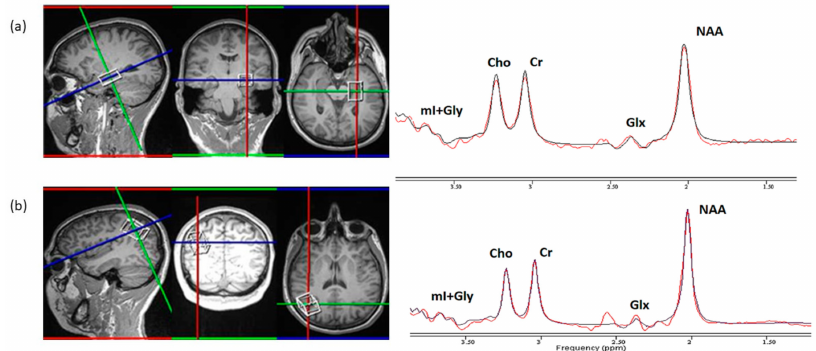
Figure 1. MRS voxel positioning. Left to right: sagittal view—coronal view—axial view—representative region-specific MR spectrum. mI + Gly = myo-inositol + glycine; Cho = choline; Cr = creatine; Glx = glutamate and glutamine, and NAA